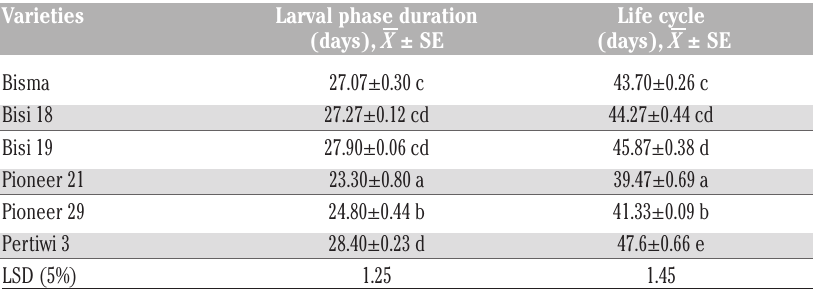
Table 5. Mean value of larval phase, and life cycle of S. zeamais in six varieties of corn using NTCM.